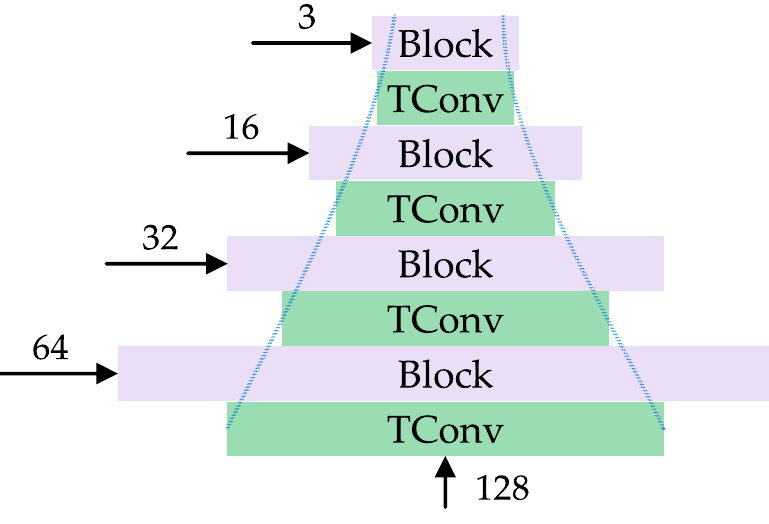
Figure 8. Schematic illustration of decoder feature width.